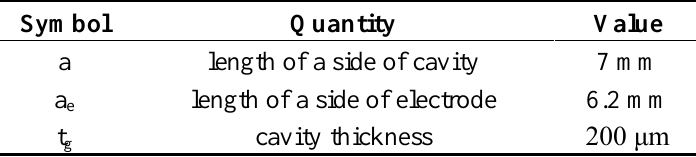
Table 2. Geometrical parameters of capacitor design.